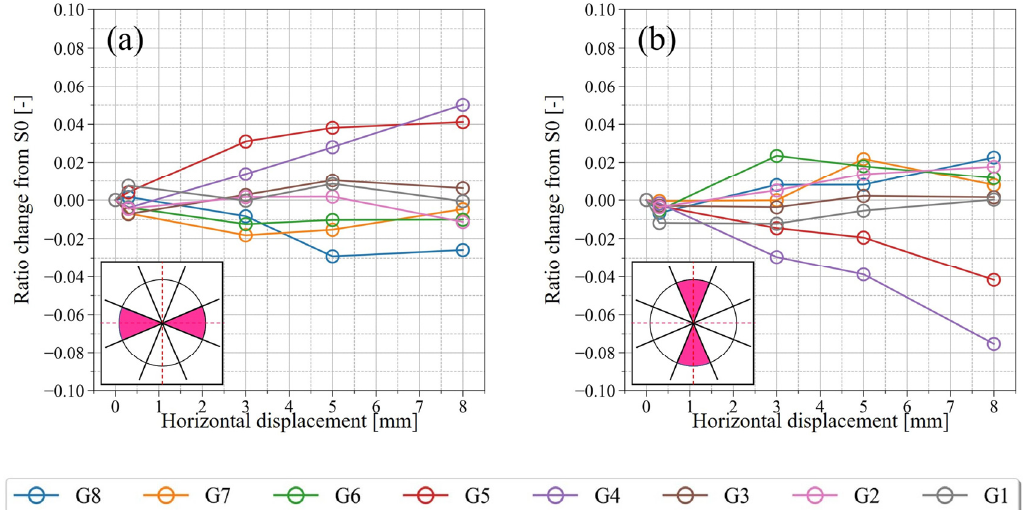
Figure 19. Variation in the ratio of the particle’s short axis from S0 (initial state). ( a ) 337.5–22.5 ° and 157.5–202.5 ° , and ( b ) 67.5–112.5 ° and 247.5–292.5 ° .